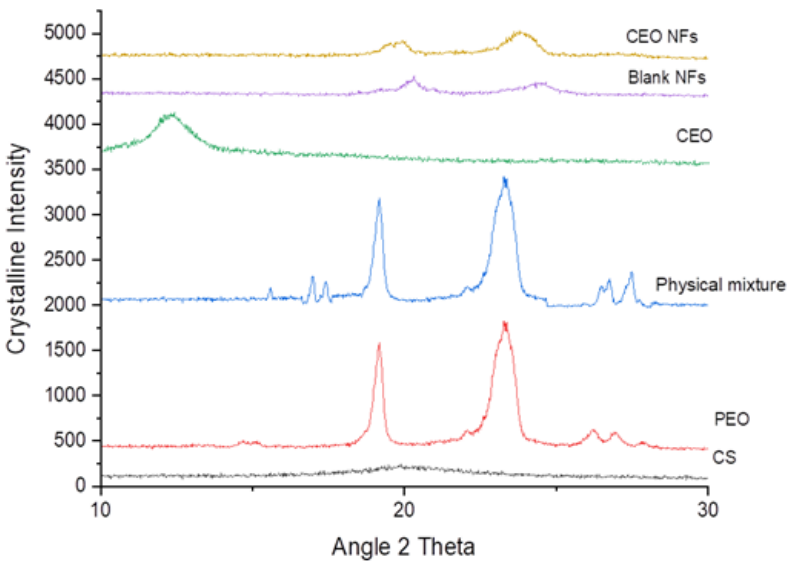
Figure 4. The XRD analysis of CS, PEO, physical mixture (CS-PEO with CEO), CEO, Blank NFs, and CEO-encapsulated NFs.